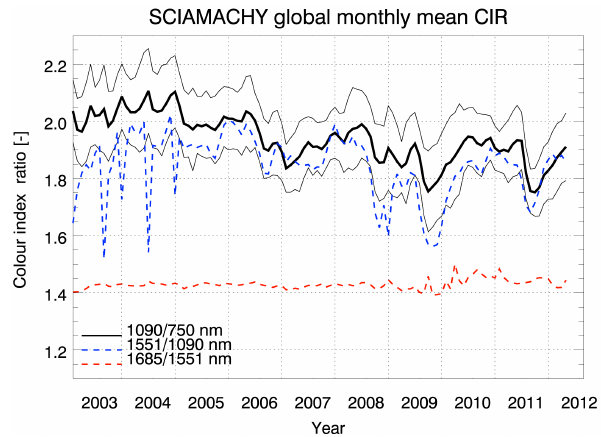
Figure 10. Global monthly averages of the SCIAMACHY colour index ratio CIR for the 1090 / 750nm wavelength pair and its 1 σ standard deviation. Also plotted are two different CIRs using the ratios of 1551 / 1090nm (blue dashed line) and 1685 / 1551nm (red dashed line).